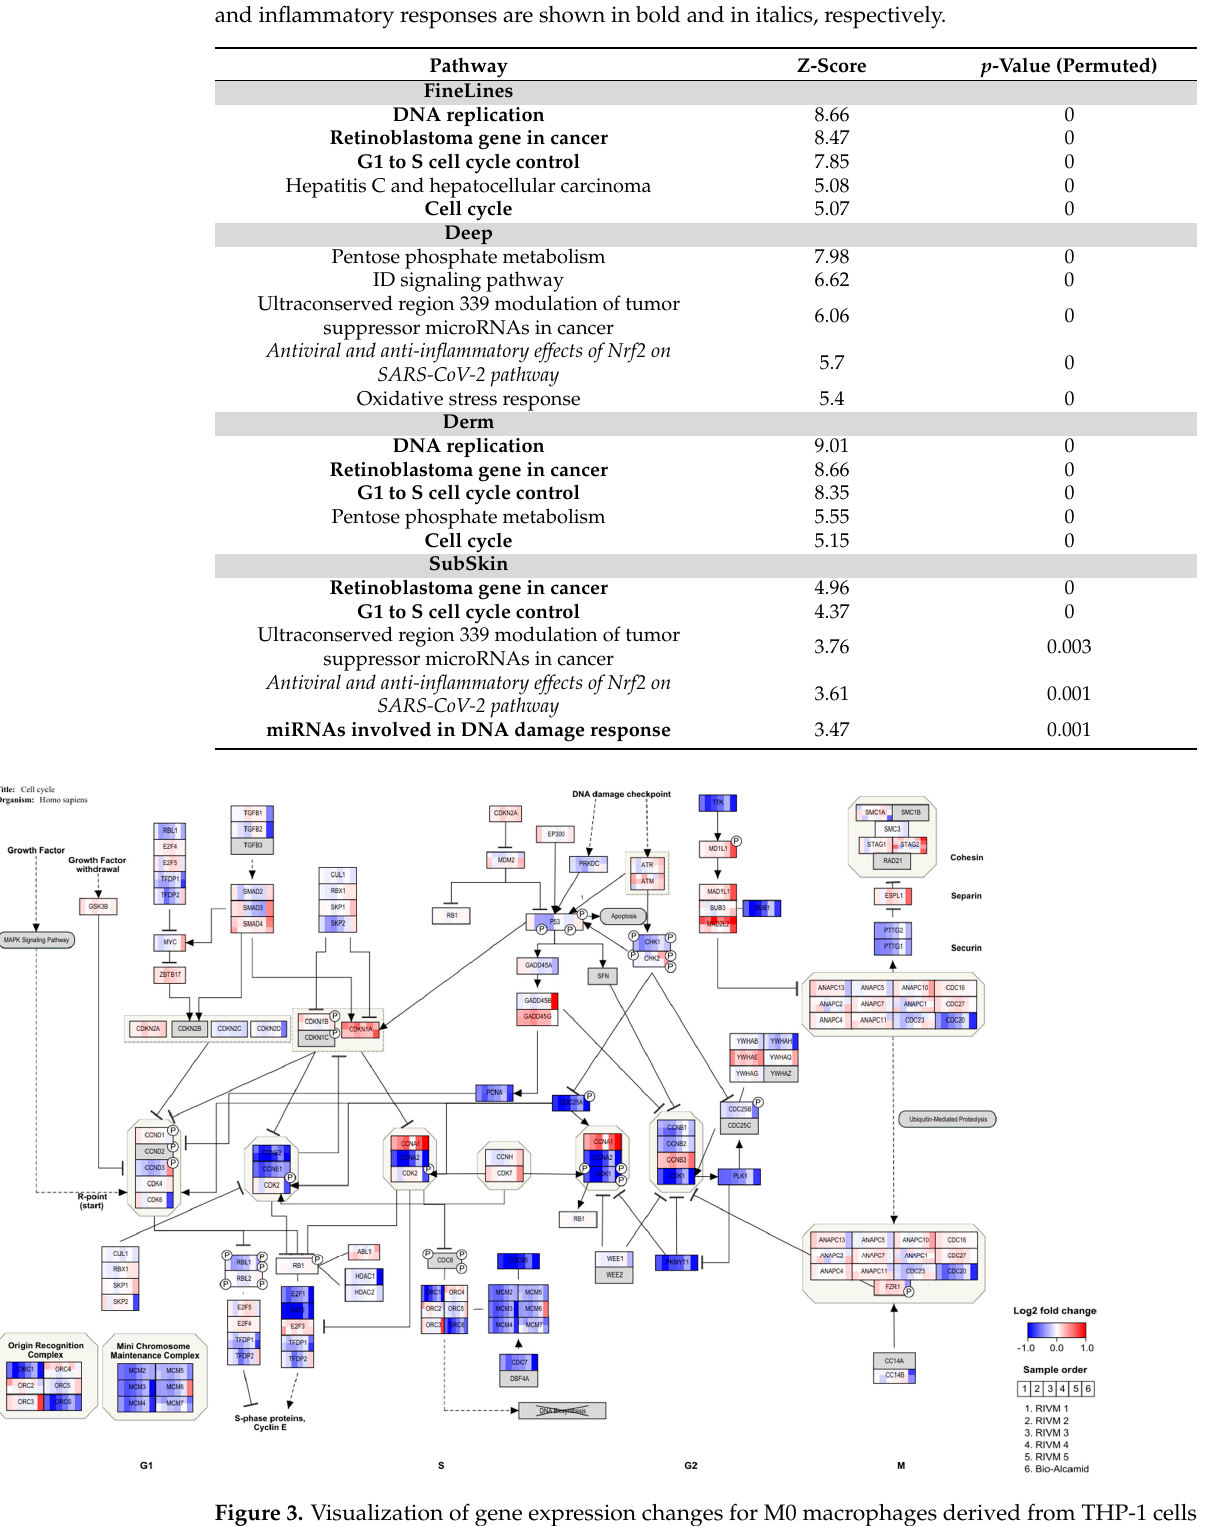
Figure 3. Visualization of gene expression changes for M0 macrophages derived from THP-1 cells exposed to RIVM preparations and Bio-Alcamid ® extracts on the cell cycle pathway. Cells were exposed for 24 h to extracts of the various HA fillers. At 24 h, the cells were harvested and RNA isolated for cDNA preparation and microarray gene analysis.